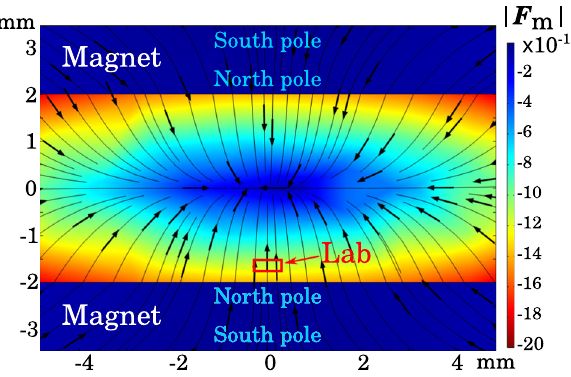
Fig. 16 The magnetic force field of the considered setup for two 1.25 T neodymium magnets, in units of 10 − 12 N. The separation between the two magnets (depicted in dark blue) is 4 mm. The radius of the magnets on the plane parallel to the orbits is 15 mm. The equilibrium position of the Satellite is approximately 300 μ m above the north pole of the lower magnet. The Lab zone is represented by a red rectangle. We used the COMSOL Multiphysics (cid:3) software to perform the modeling